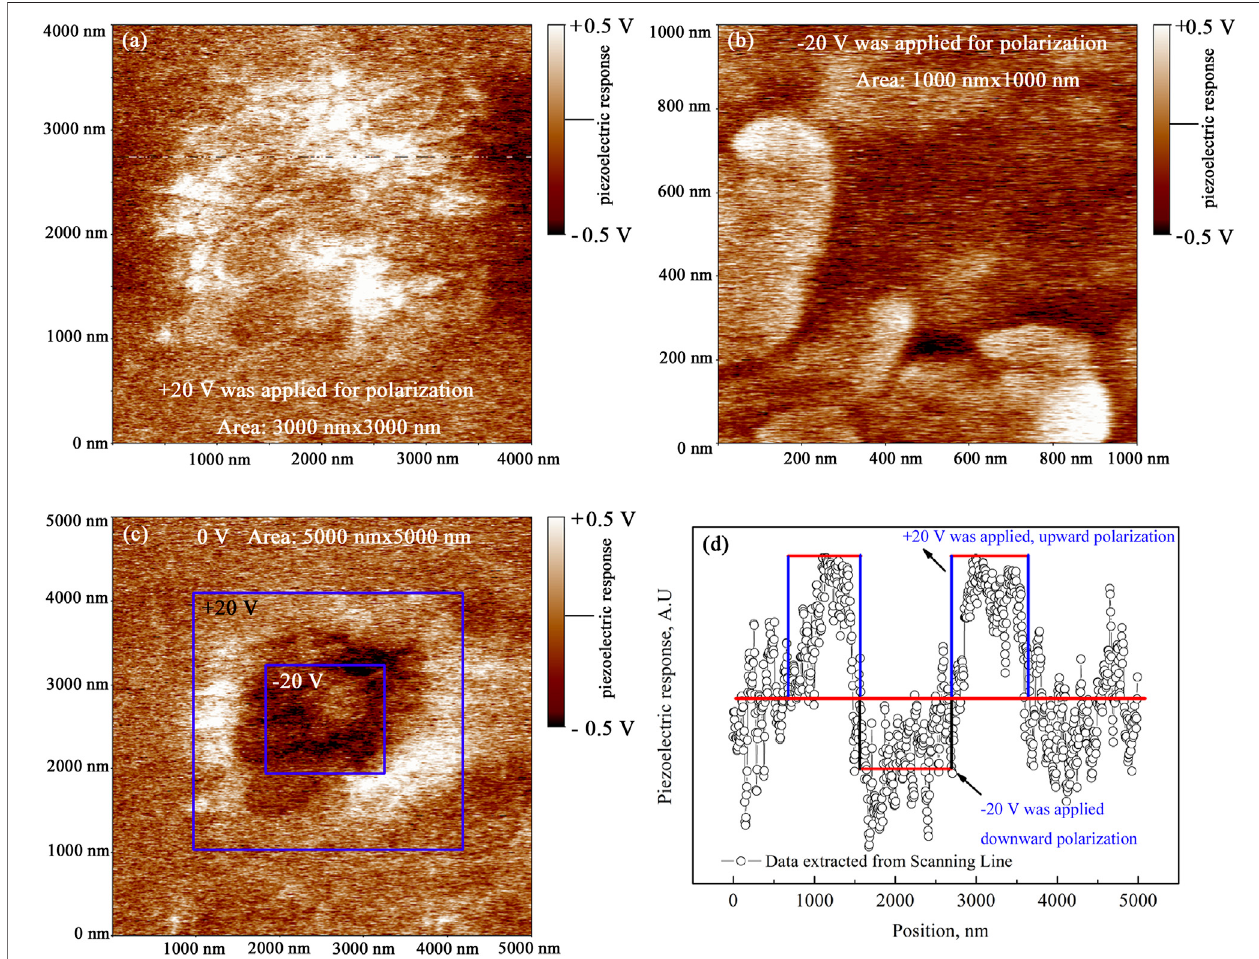
FIGURE 6 | PFM images of the BZT/PZT/BZT/LNO thin fi lm. (A) + 20 V polarization voltage. (B) − 20 V polarization voltage. (C) Scanning after voltage was removed. (D) Piezoelectric response extracted from a scanning line in Fig. (C) .